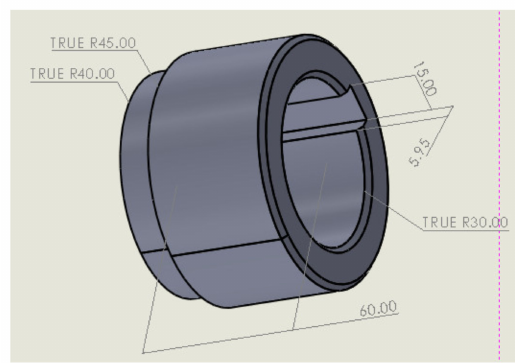
Figure A4. Hub (Dimensions in mm).